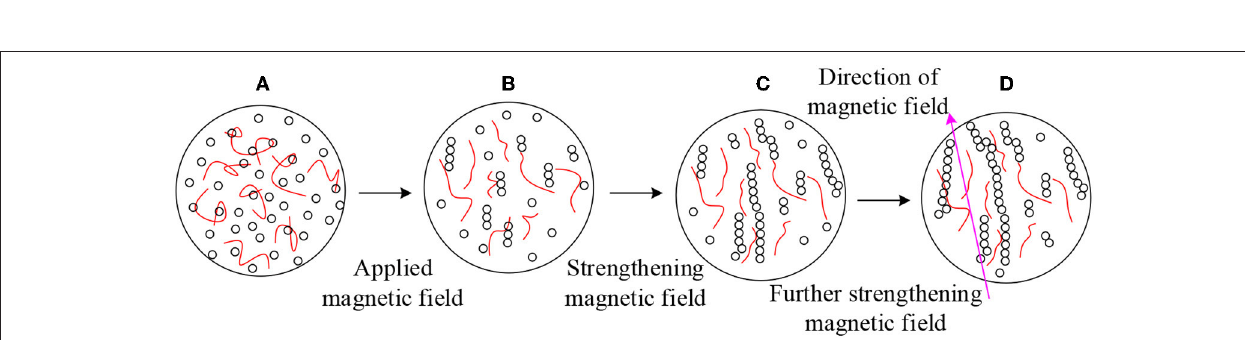
FIGURE 3 | Internal chain forming process (red solid line represents polyurethane polymer, and hollow small circle represents CIPs). (A) no magnetic field; (B) applying a weak magnetic field; (C) magnetic field enhancement and (D) further strengthening of magnetic